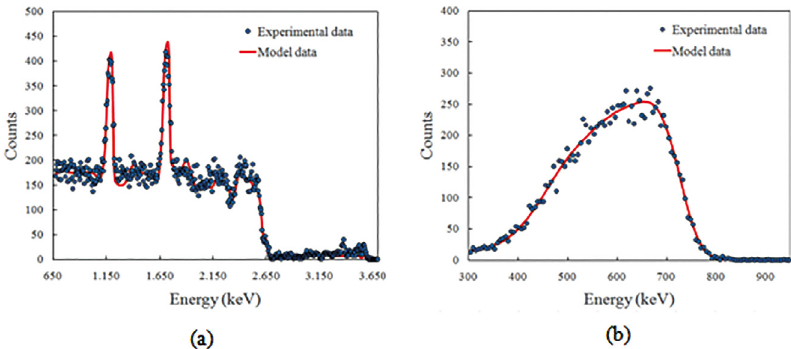
Figure 5. Experimental data (dots) with the simulated spectrum for the sample prepared with the grounded holder, for (a) EBS (C, O, Al) and (b) ERD (H)